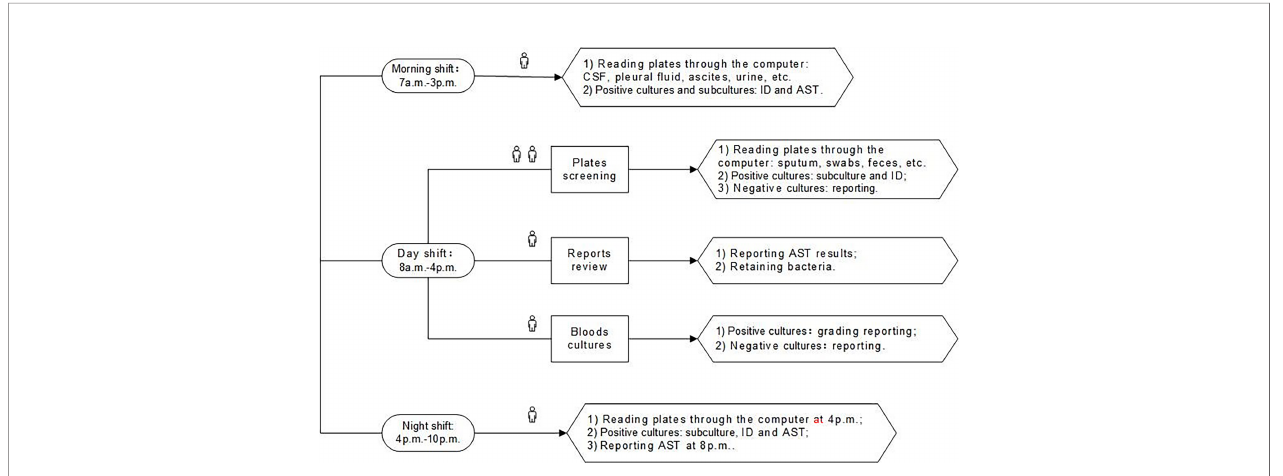
FIGURE 2 | The three shifts of post-TLA: one person for morning shift, four people for day shift, and one person for night shift. CSF, cerebrospinal fl uid; ID, identi fi cation; AST, antimicrobial susceptibility testing; TLA, total laboratory automation.